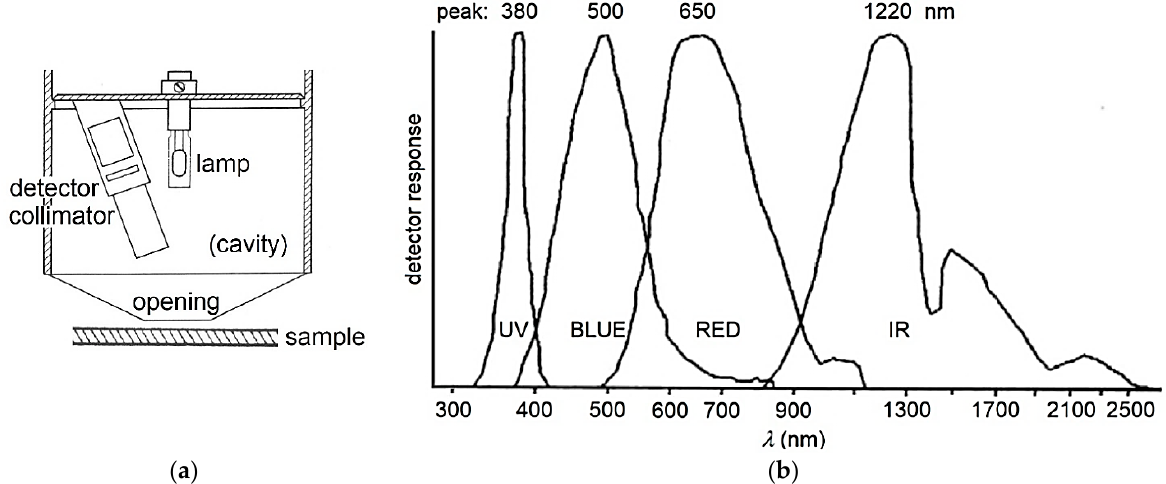
Figure 2. Solar spectrum reflectometer head ( a ), sketch redrawn from [47] and sensitivity curves of the embedded detectors ( b ); patterns retraced from [48].